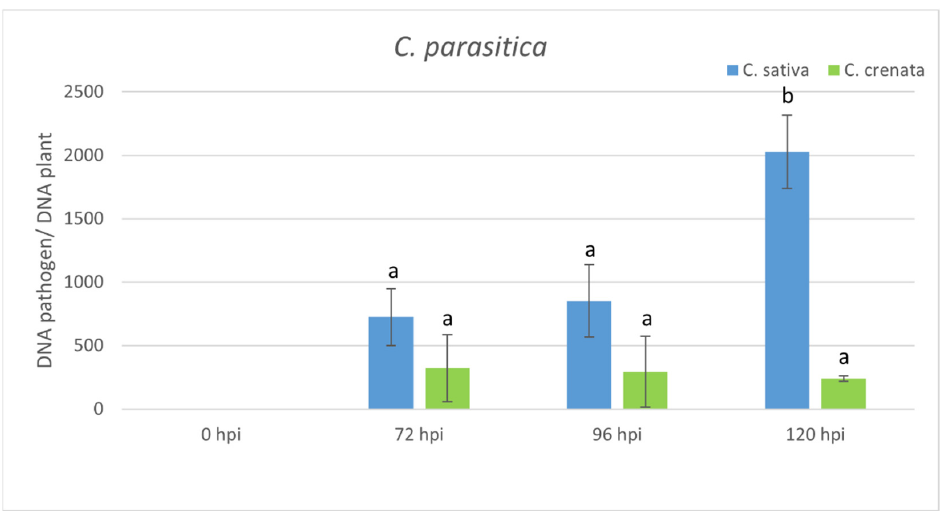
Figure 6. qRT-PCR pathogen DNA quantification after C. parasitica inoculation. Data were quantified using the 2 −ΔΔ Ct method based on the Ct values of fungal genes (ypt and mf1) with actin-7 as a housekeeping gene. Data are the means of three biological replicates ± SE. C. sativa data are normalized with the C. sativa 0 hpi control; C. crenata data are normalized with C. crenata 0 hpi control. Different letters associated with the set of means indicate a significant difference based on Tukey’s HSD test ( p ≤ 0.05).